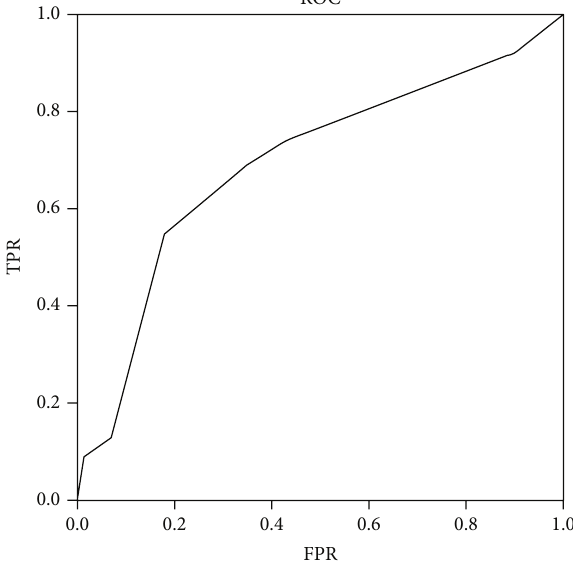
Figure 5: Experimental ROC curve.